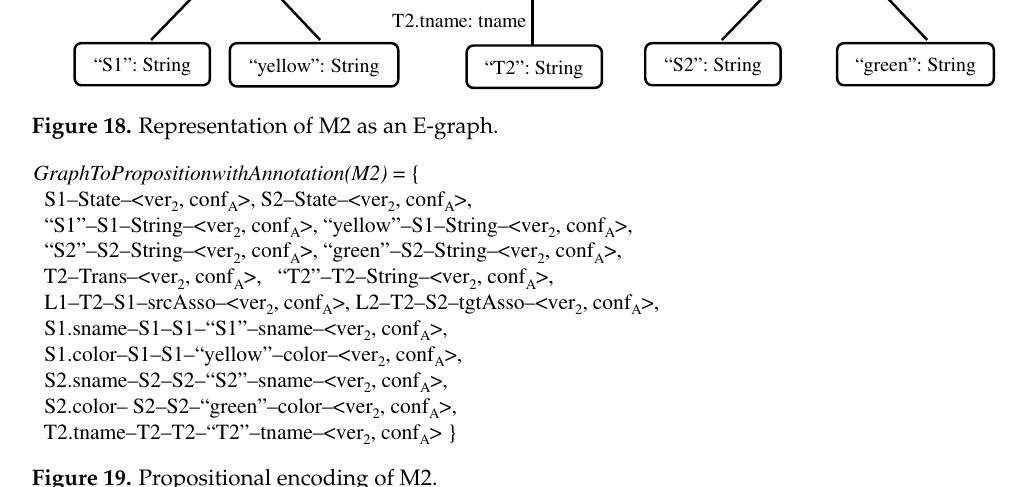
Figure 19. Propositional encoding of